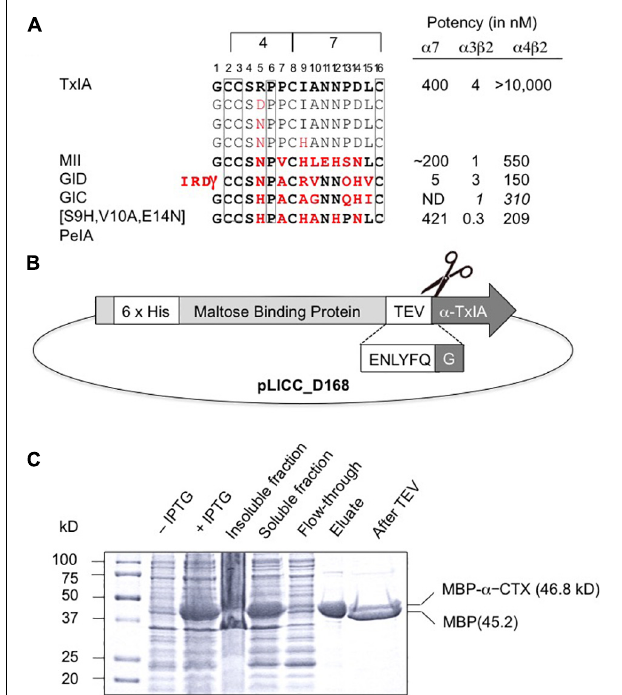
FIGURE 1 | Recombinant production of TxIA. (A) Amino acid sequence alignment of native and mutant analogs of TxIA with α -conotoxins that show some affinity to α 4 β 2 nAChRs, and their respective IC 50 values (for references see, Dutertre et al., 2017). Italics indicate values at human nAChR isoforms. Conserved cysteine residues are shown in boxes. The number of residues between the cysteines defines the 4/7 α -conotoxin subfamily. Residues in MII, GID, GIC, PeIA that differ from TxIA are shown in bold red. Mutated TxIA residues in position 5 and 9 are also highlighted in red. IC 50 values refer to studies using Xenopus laevis oocytes. (B) Schematic representation showing the design of the pLic-MBP plasmid used for periplasmic expression of disulfide-rich peptides in Escherichia coli . The construct encodes a His 6 tag for affinity purification, followed by a MBP fusion tag for solubility and a TEV protease recognition site between the MBP and the TxIA sequences. (C) Coomassie Blue stained SDS-PAGE gels showing samples of the fusion construct obtained during different steps of recombinant peptide production and purification. The difference in molecular mass between the concentrated eluate before (second last lane) and after (last lane) TEV protease cleavage indicates cleavage of TxIA from the His 6 -MBP.